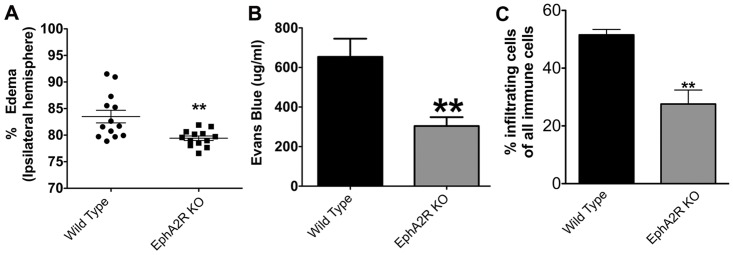
EphA2−/− mice have reduced post-stroke blood-brain barrier (BBB) leakage, edema and infiltrating immune cells.(A) Quantitative measurement of brain edema in ipsilateral brain hemisphere by the wet-dry method. EphA2−/− mice have lower levels of post-stroke brain edema in comparison with wild type mice. (B) Quantitative measurement of Evans Blue dye extravasation in ipsilateral brain hemisphere. Evans Blue dye content was significantly lower in brains from EphA2−/− mice compared with wild type. (C) Flow cytometry analysis of the ipsilateral hemisphere following 72 h of reperfusion showed significantly fewer infiltrating (CD45high) immune cells in EphA2−/− mice compared to vehicle treated controls. Data are means ± SEM from 12 to 13 animals. **p<0.01 relative to wild type.